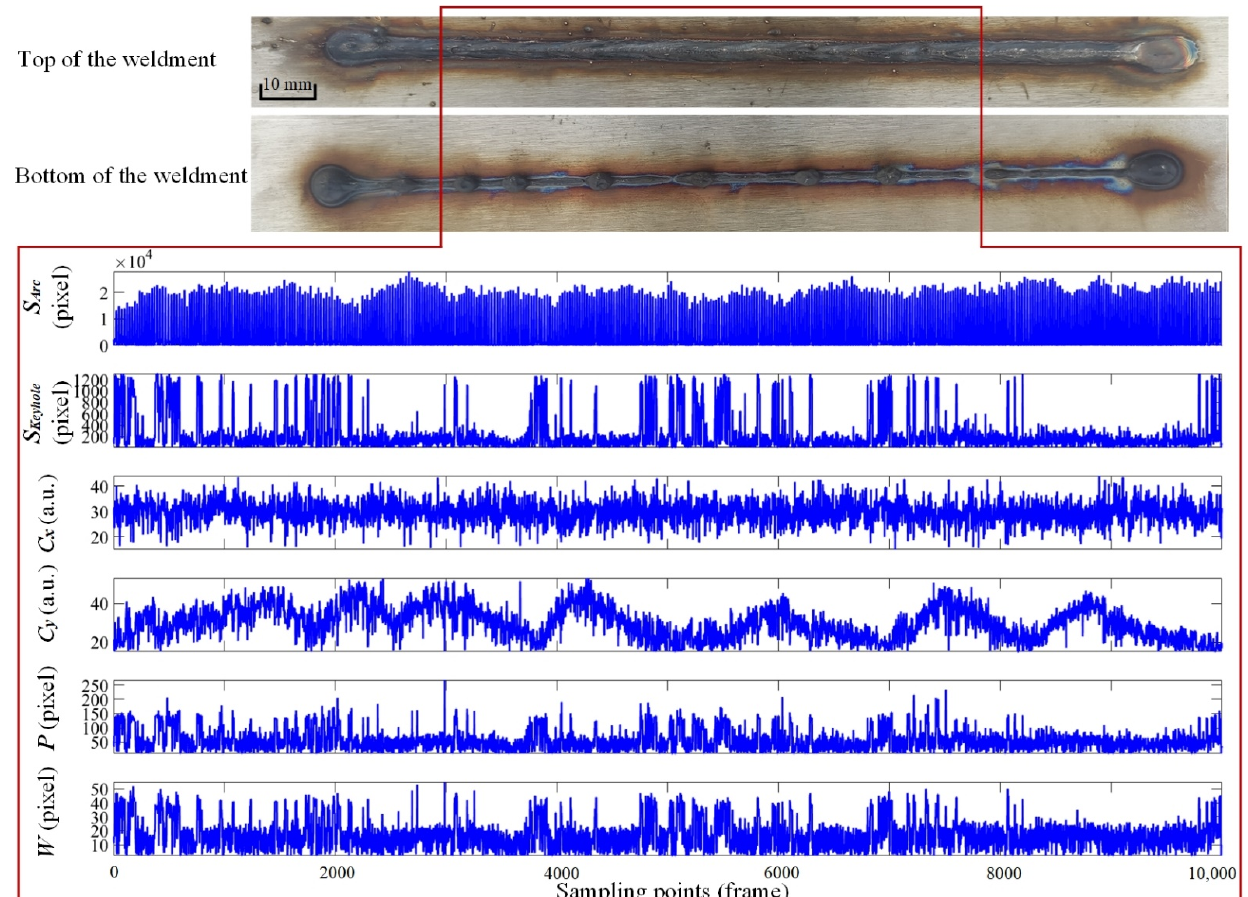
Figure 8. Visual features of partial penetration (No.2) in the laser ‐ MIG hybrid welding process.